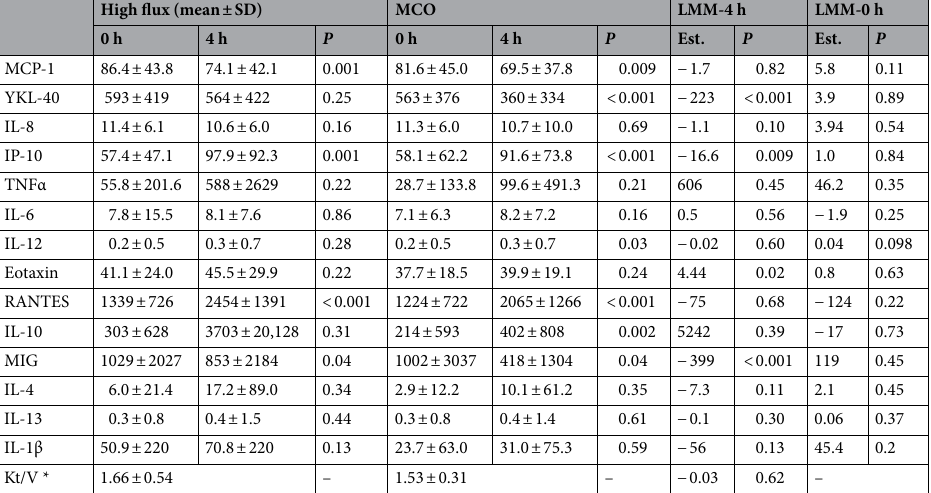
Table 3. Extended endpoint analysis—single session and long-term comparison of MCO versus high flux. The table reports mean ± standard deviation (SD) of inflammatory mediators as specified in the left column during MCO versus high flux treatment at T1 and T3—intention to treat population (n = 42 and n = 37 patient × treatment pairs respectively). Interleukin concentrations were assayed as follows: TNFα, IL-10, IL-4, IL-13, IL-1β: fg/ml; MCP-1, IL-8, IP-10, IL-6, Il-12, Eotaxin, RANTES, MIG, IL-4: pg/ml; YKL-40: pg/ml. Pre-versus post-dialysis intra-individual decline or increase was assessed using paired-t-tests within the treatment arms and 0 h and 4 h serum mediator levels, respectively. In the right two columns results from linear mixed effects models (LMM) [using subject ID, nested in sequence as a random effect and treatment (MCO = 1), period and sequence as the main effects] are displayed for post-HD (4 h) values and pre-HD (0 h) values, respectively. Herein, the 4 h LMM compares single session kinetics, whereas the 0 h model tests for long term differences (over a period of 3 months). Estimate (Est.); Eosinophil chemotactic protein (EOTAXIN), * Kt / V was calculated according to Daugirdas = − ln((Post BUN/Pre BUN) − (0.008 × Dialysis duration)) + (4 − 3.5 × (Post BUN/Pre BUN)) × (UF/Weight). Data for calculation of means was used at T1 and T3—intention to treat population (n = 31 and n = 22 patient × treatment pairs respectively); Interleukin (IL); Interferon-inducible protein